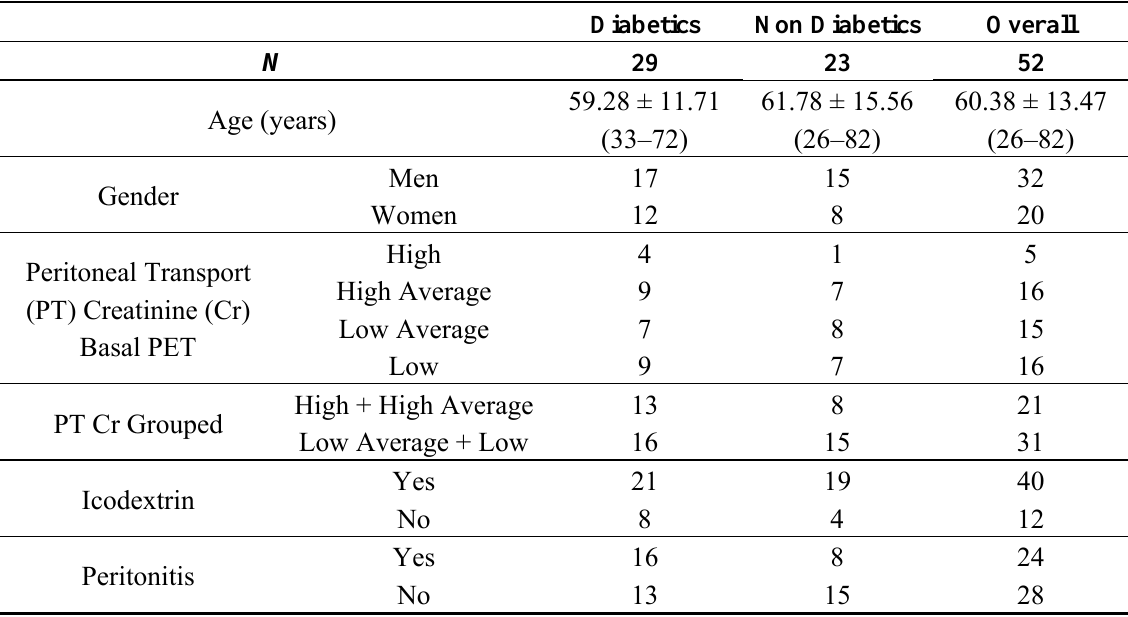
Table 1. Characteristics of diabetic and non-diabetic